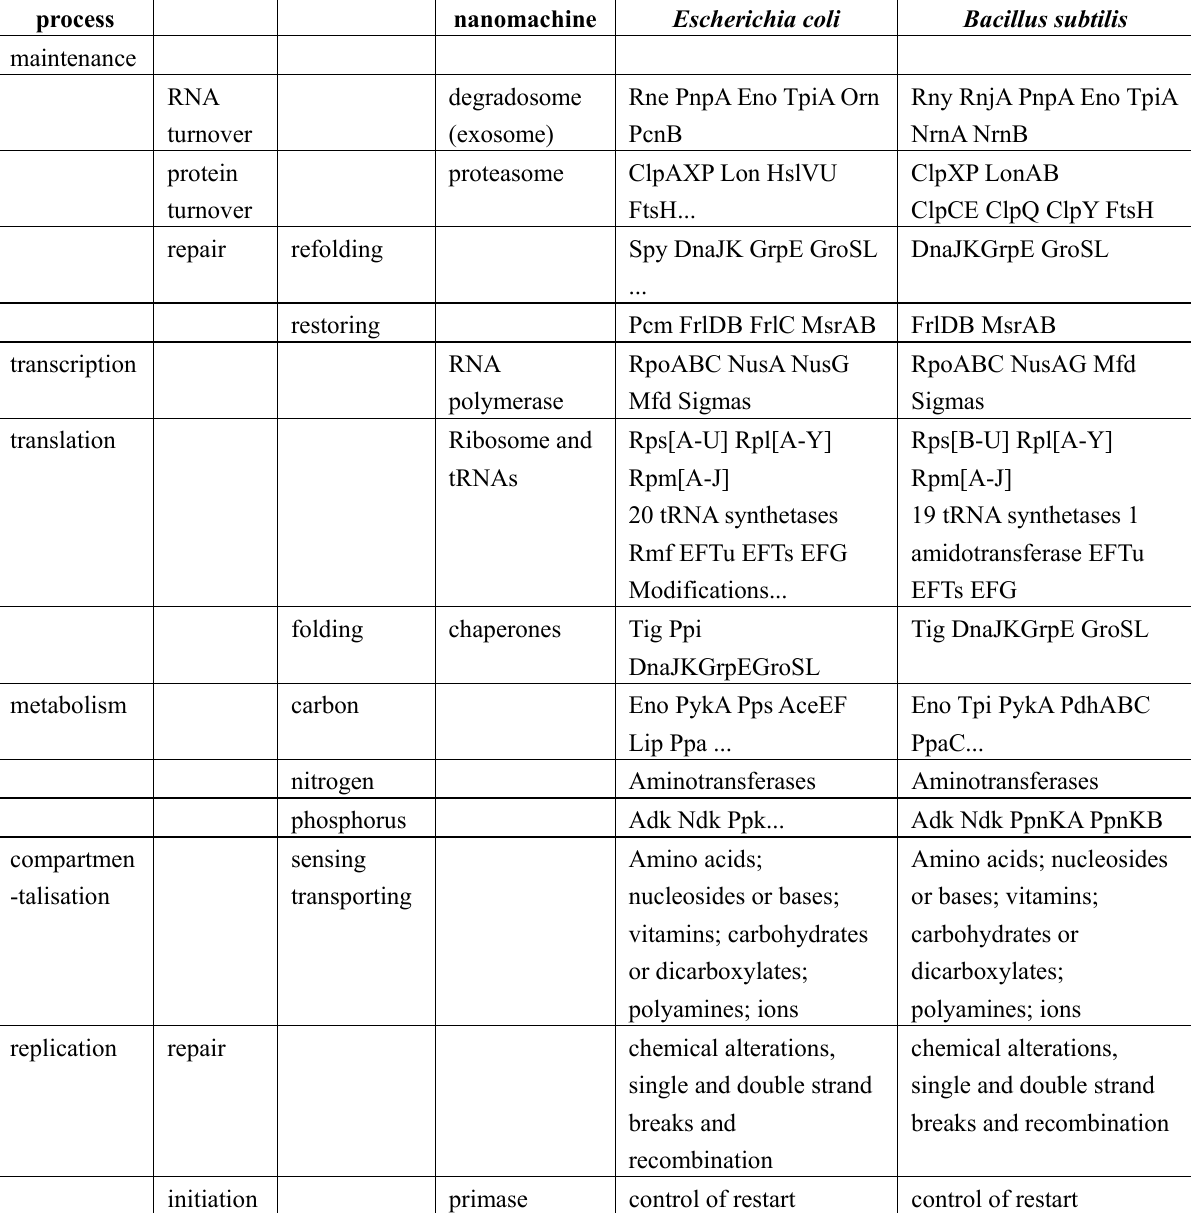
Table 1. Functions, processes and metabolites that must be active during the cell’s stationary phase